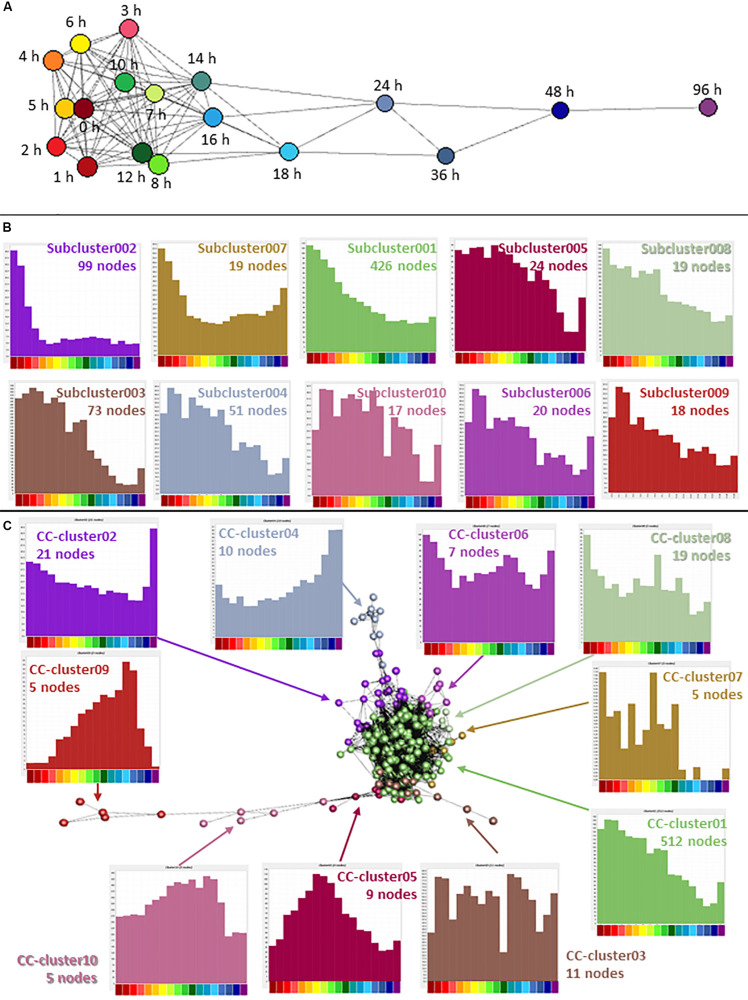
Network analysis of cell cycle genes. (A) Sample-to-sample analysis of Cluster002, containing genes associated with the cell cycle and proliferation. Nodes show averaged values for each time point and edges show correlations of ≥0.90 between nodes. Hours after addition of PMA are indicated. (B) Expression profiles of subclusters generated by gene-to-gene analysis of Cluster002. Averaged values for each time point. Correlation coefficient was ≥0.95 and MCL inflation value was 1.7. (C) Gene-to-gene analysis of 561 curated cell cycle genes (617 TSS) (Giotti et al., 2018) expressed during THP-1 differentiation. Nodes show averaged values for each gene and edges show correlations of ≥0.75 between them. MCL inflation value was 1.7. Histograms show the averaged expression profile for each cluster. Color code for the X axis is as for Figure 2.